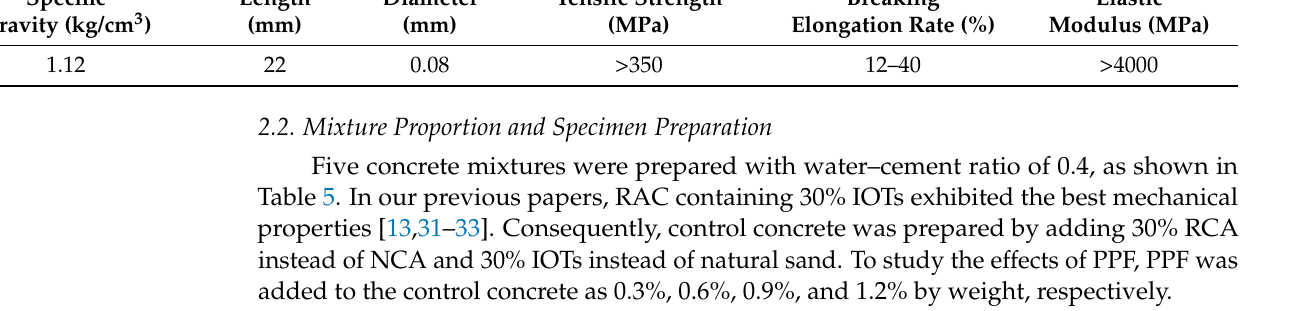
Table 5. Mixture